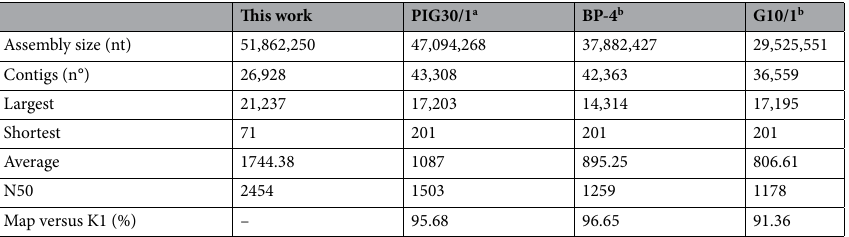
Table 1. Tritrichomonas foetus transcriptomes statistics. This work: Guided assembly performed in this work using Tritrichomonas foetus K1 genome as reference. Map versus K1 (%) refers to the mappability rate of isolate reads against reference used in this work. a Summary of transcriptome statistics from Morin-Adeline et al.; 2015 18 , b Summary of transcriptome statistics from Morin-Adeline et al.; 2014 11